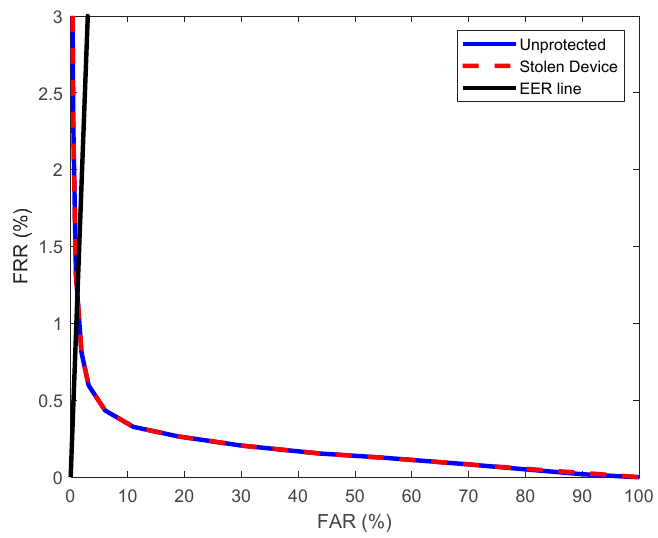
Figure 8. DET Curves for the unprotected and the stolen device scenario obtained from LFW database with Classic McEliece mceliece6688128 parameter set.